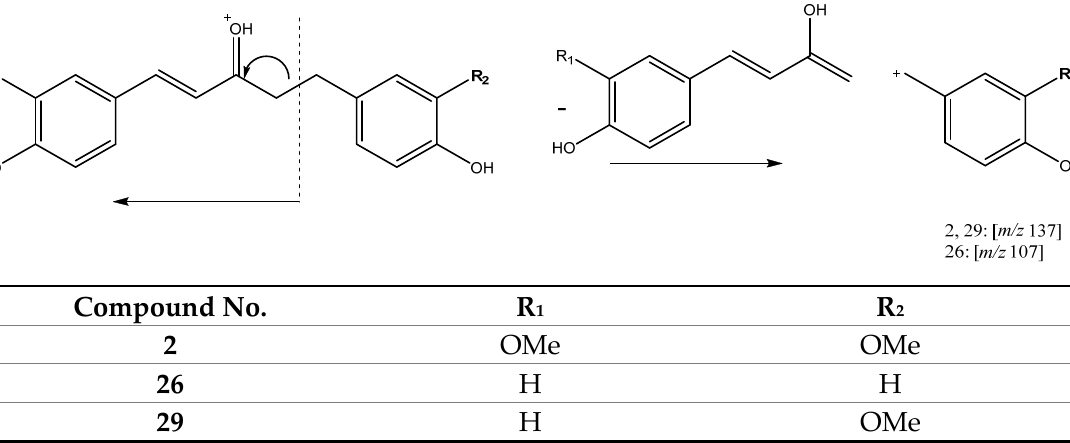
OMe Figure 8. Fragmentation pathway for peaks 11 and 12 .